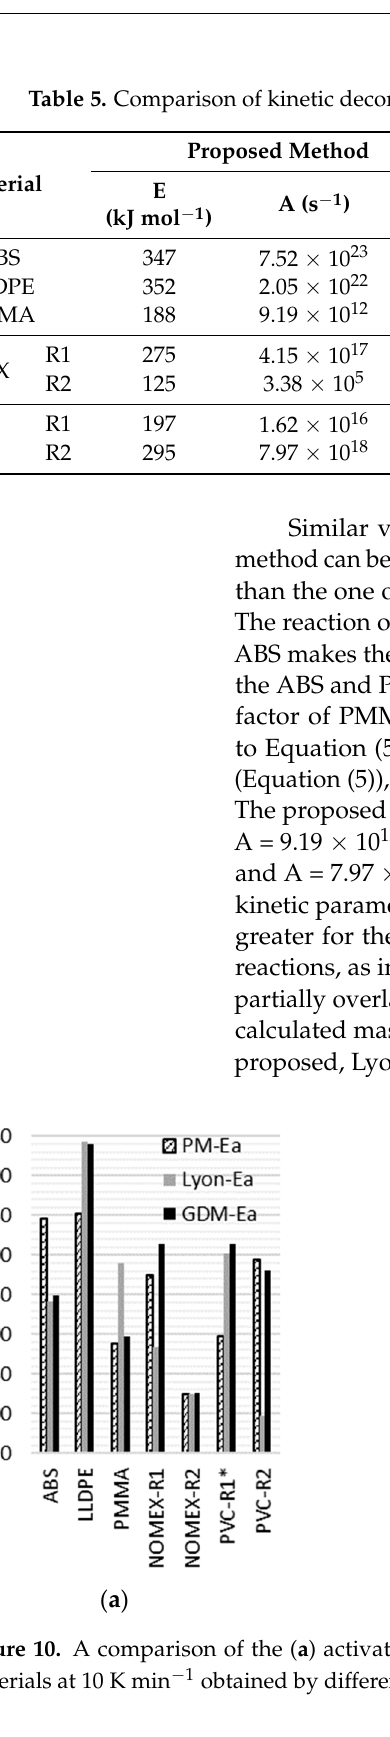
Table 5. Comparison of kinetic decomposition parameters for five materials at a heating rate of 10 K min − 1 .